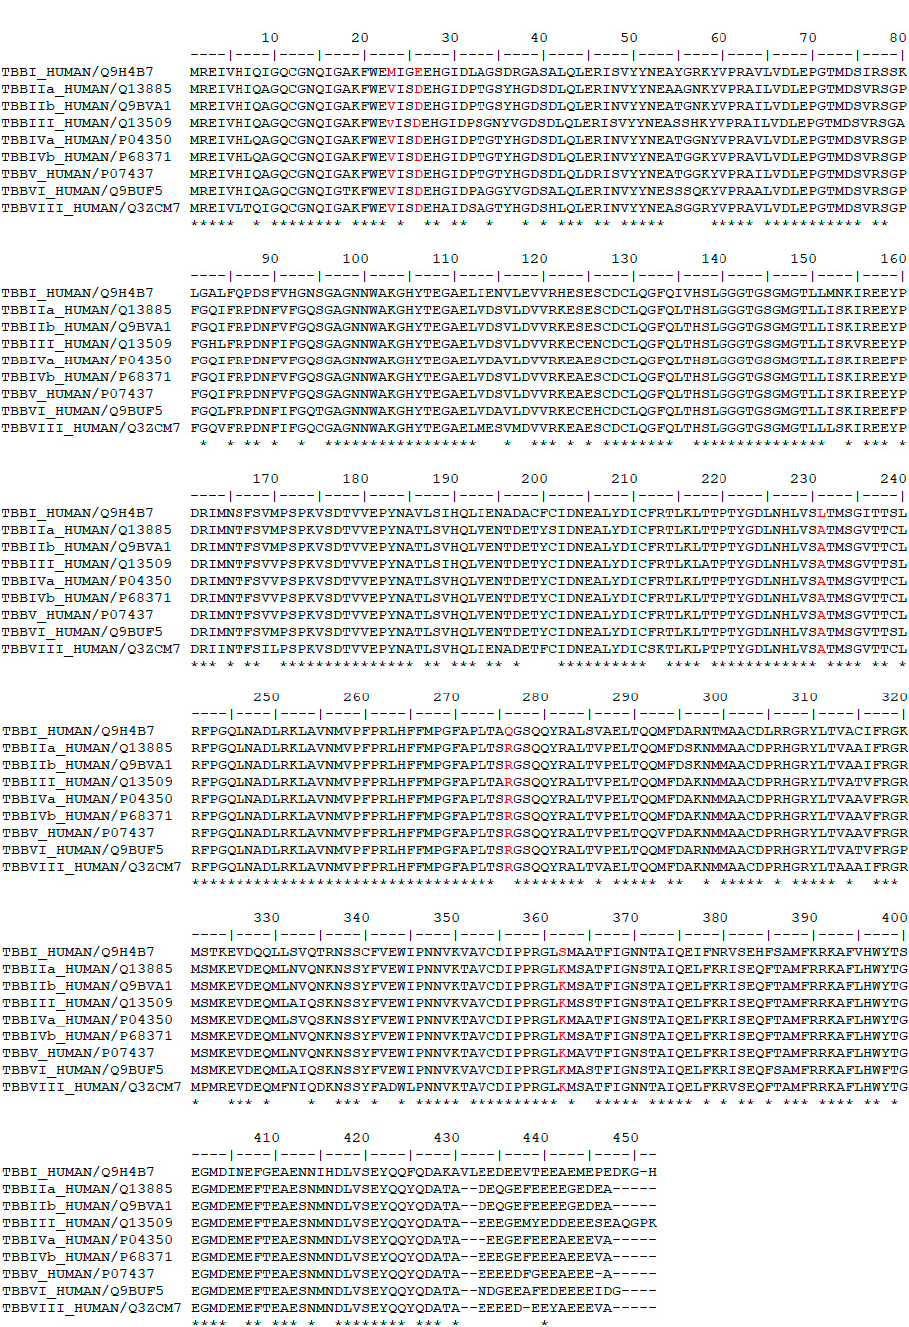
Figure 2. Multiple sequence alignment of human β -tubulin isotypes. The isotype β I shows variations of residues Arg276-Gln, Lys362-Ser, Val23-Met, Ala231-Leu, and Asp26-Glu at the griseofulvin binding pocket. Residue variations in the griseofulvin binding pocket are shown in red. Symbol ‘*’ demonstrates amino acid positions, which have a fully conserved amino acid residue.